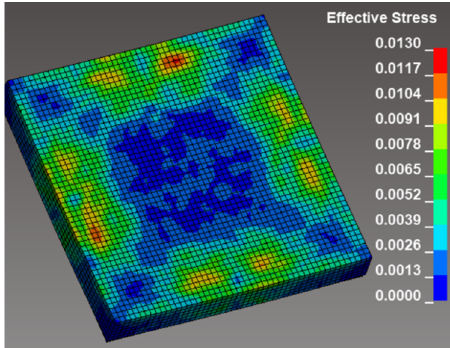
Figure 6. Modelling of the blast load of the concrete slab-stress (GPa) plot of the specimen in 3 ms time instant.